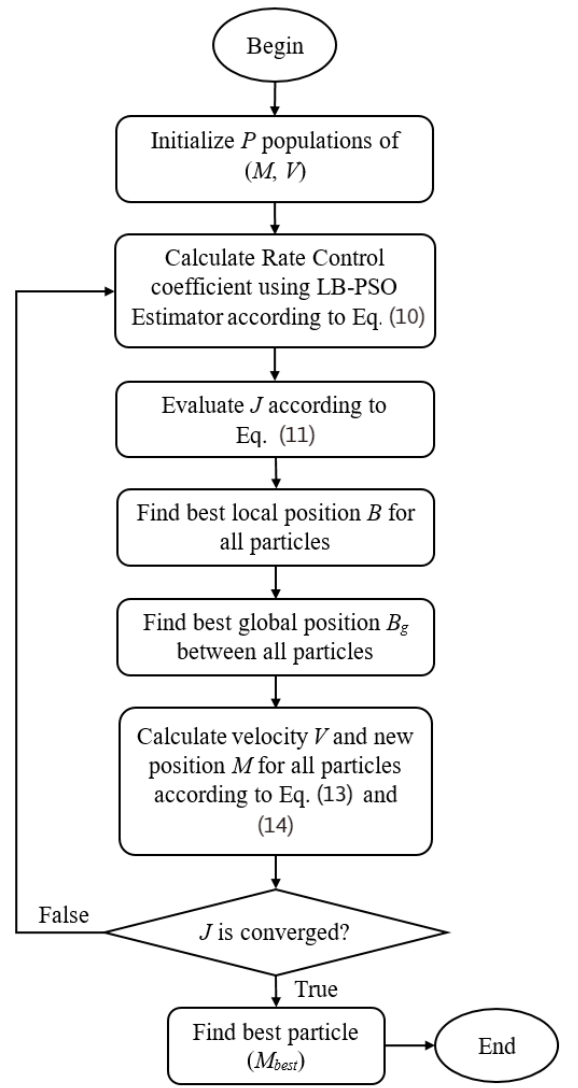
Figure 3. Learning-based particle swarm optimization